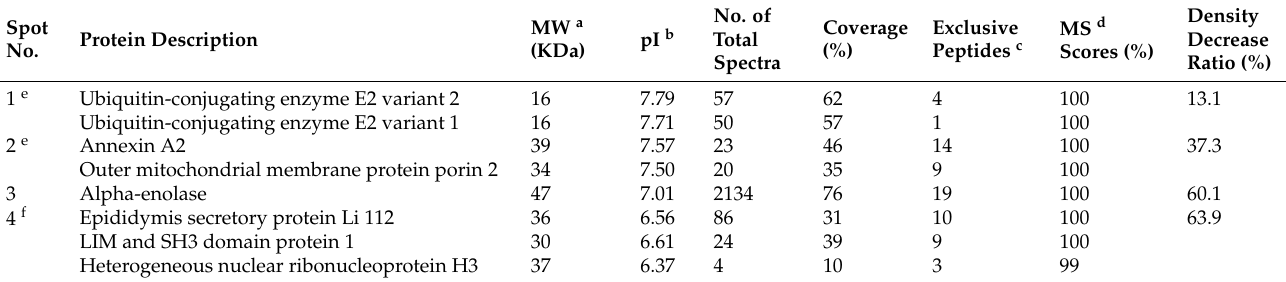
. Two potential proteins from a single spot, f . Three potential proteins from a single spot. The candidates were classified into three groups based on their Gene Ontology (Figure 6A–C). The top three significantly related molecular functions are cadherin binding, cadherin binding involved in cell–cell adhesion, and heat shock protein binding (Figure 6A). The top three markedly reported cellular components are focal adhesion, cell-substrate junction, and cell cortex (Figure 6B). In addition, the top three ranked pronouncedly related biological processes are the negative regulation of apoptotic signaling pathway, removal of superoxide radicals, and cellular response to oxygen radicals. The results are